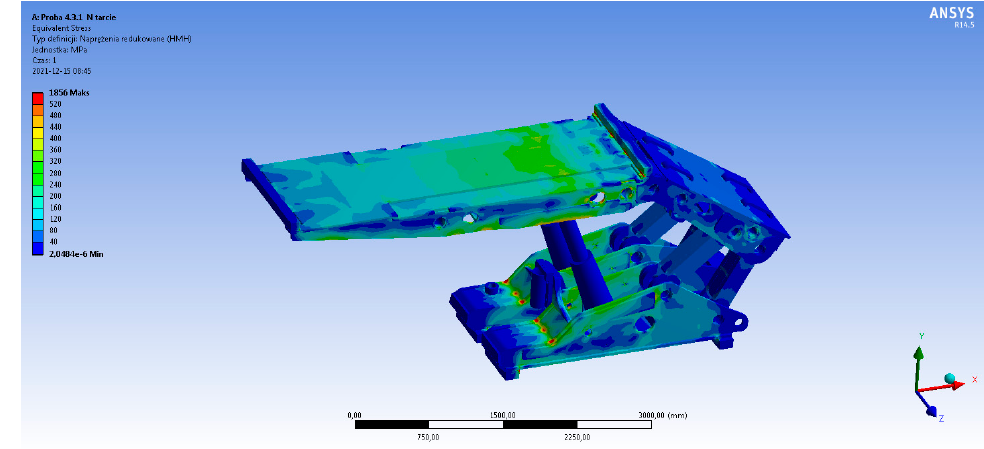
Figure 6. Load force simulation of the support’s canopy—correction.